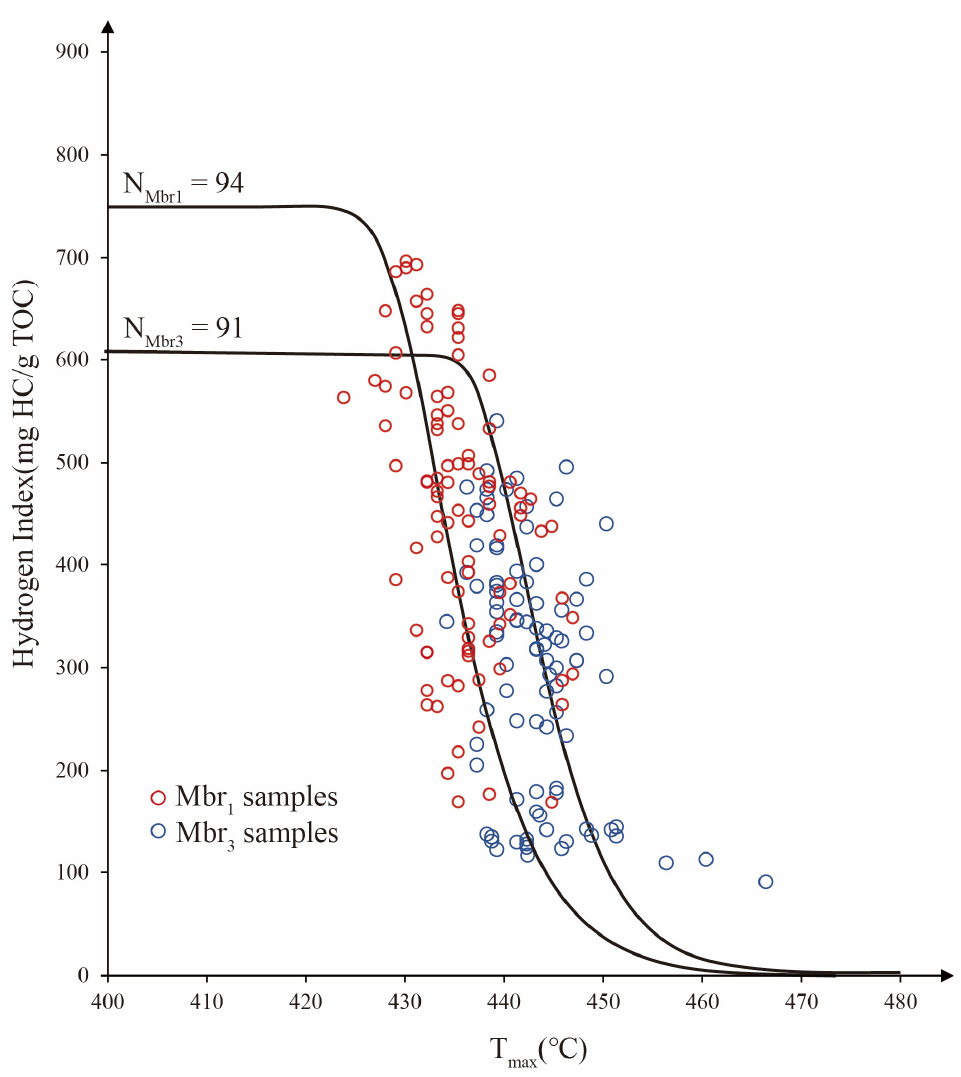
Figure 8. Fitted models between H I and T max for Mbr 1 and Mbr 3 source rocks.